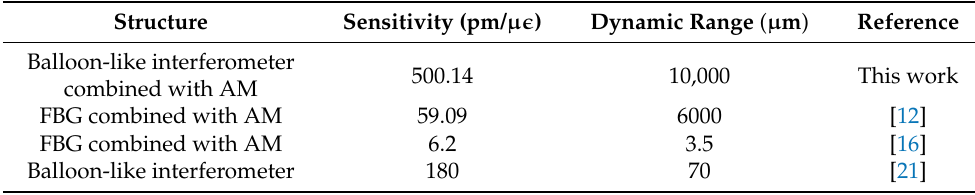
Table 1. Comparison of this work results to other works related in literature.